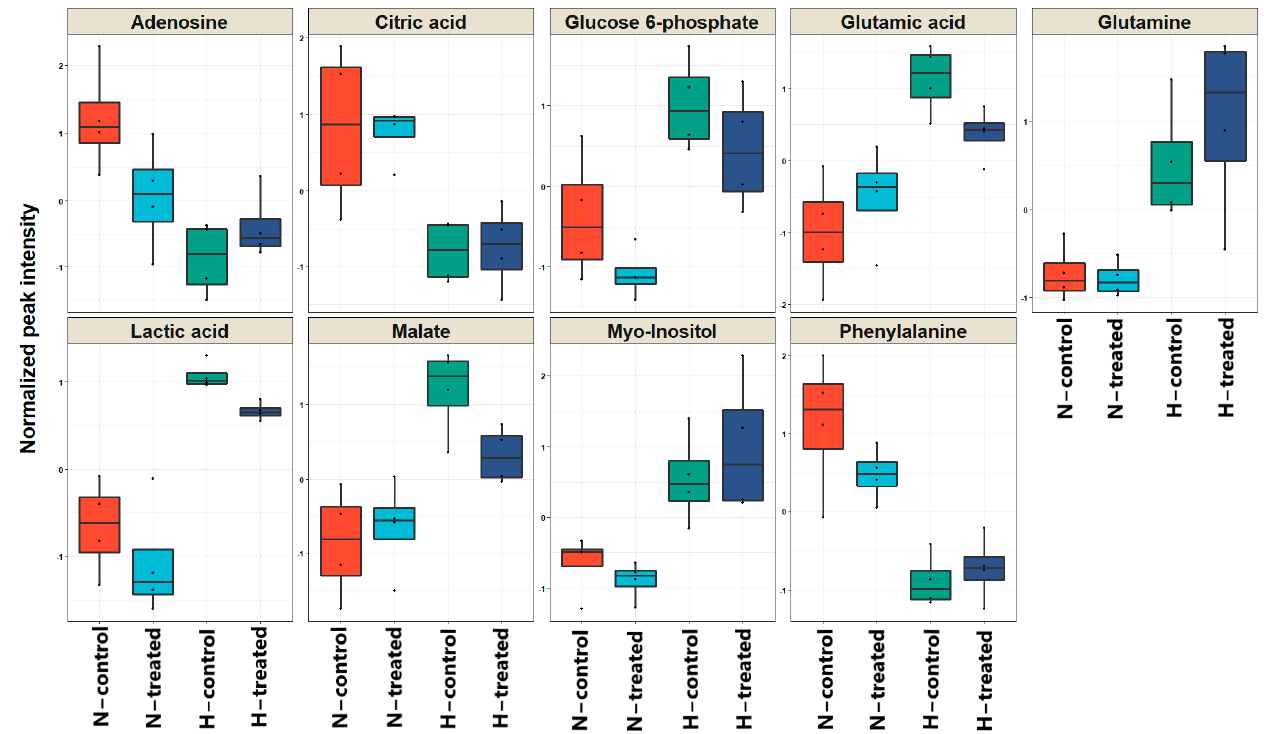
Figure 3. Boxplots of the nine most significant metabolites ( p < 0.05, VIP > 1) in the analysis of variance results comparing the four groups normal and high ‐ glucose conditions with and without PEDF. The x ‐ axis represents the specific metabolite, and the y ‐ axis is the normalised peak intensity. Key : H, high glucose; N, normal glucose .